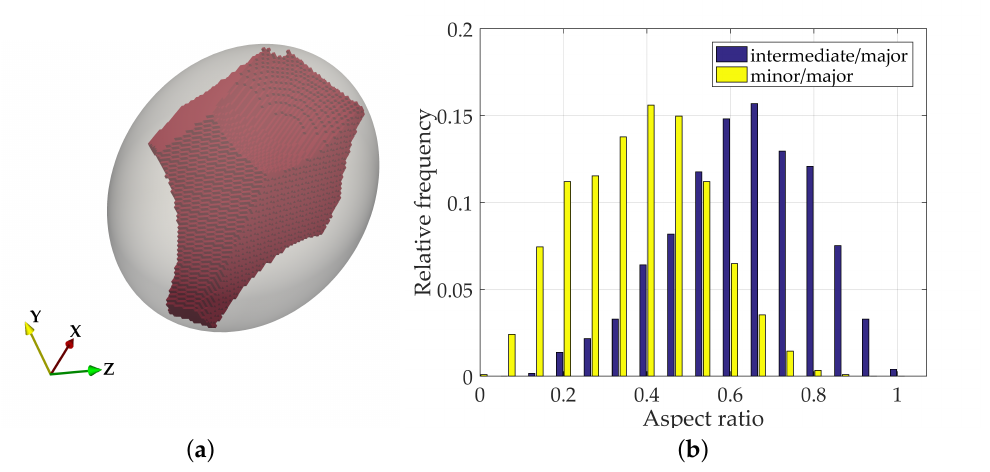
Figure 13. Pore shape distribution. ( a ) example of void and corresponding PCA ellipsoid; ( b ) aspect ratio in dense random packing